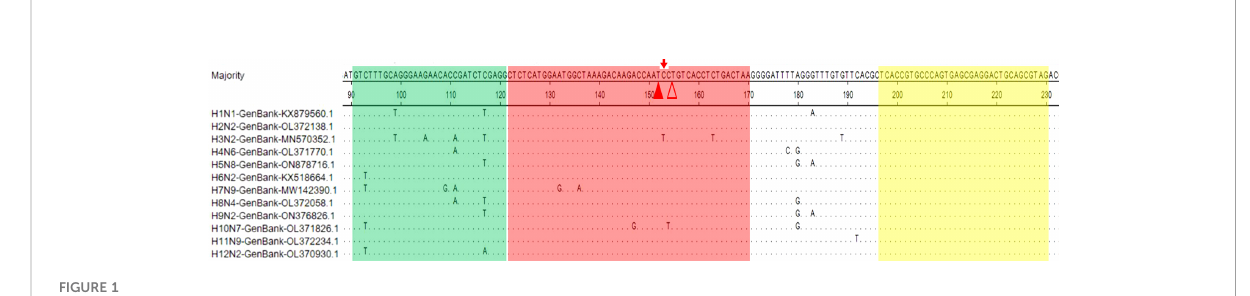
FIGURE 1 Locations of the real-time RT-RAA primers and probe on the M gene sequence of different IAVs strains. Use dots to represent nucleotide residues that match the majority. The forward primer (F91-121) is shaded in green; the reverse primer (R197-230) is blue and the exo probe (p122-170) is red. The two T residues within p122-170 labeled with a fl uorophore (FAM) and quencher (BHQ1) are marked with solid and hollow triangles, respectively. THF is marked with